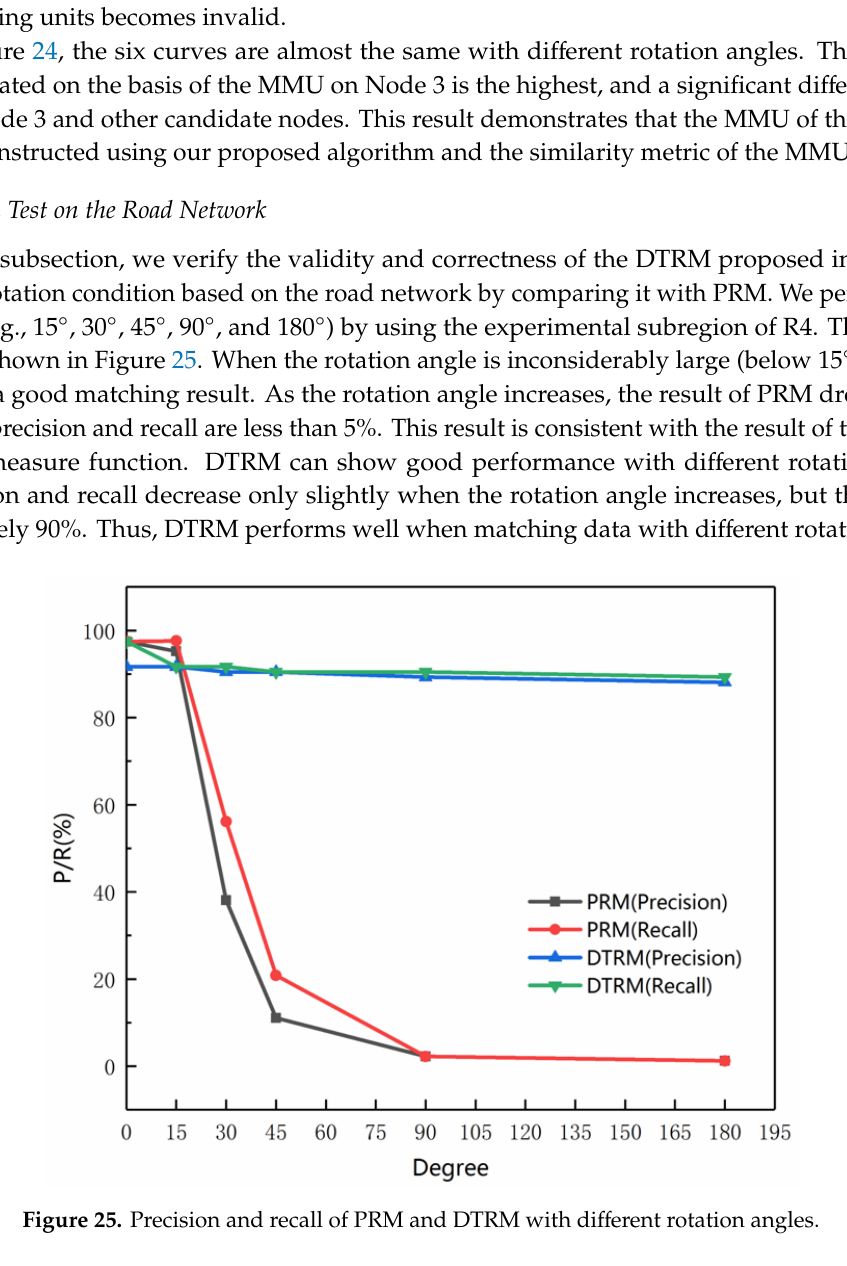
Figure 24. Similarity curves of six pairs of nodes with the same name under different rotation angles after probability relaxation iteration by using DTRM.